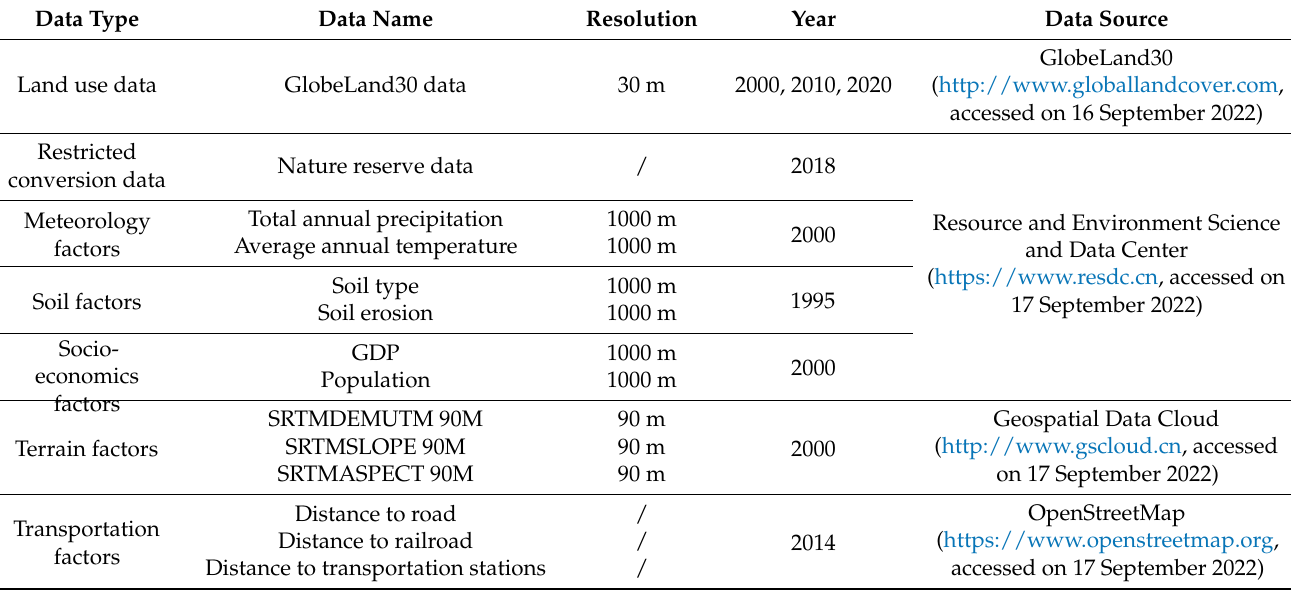
Table 1. Land use data and driving